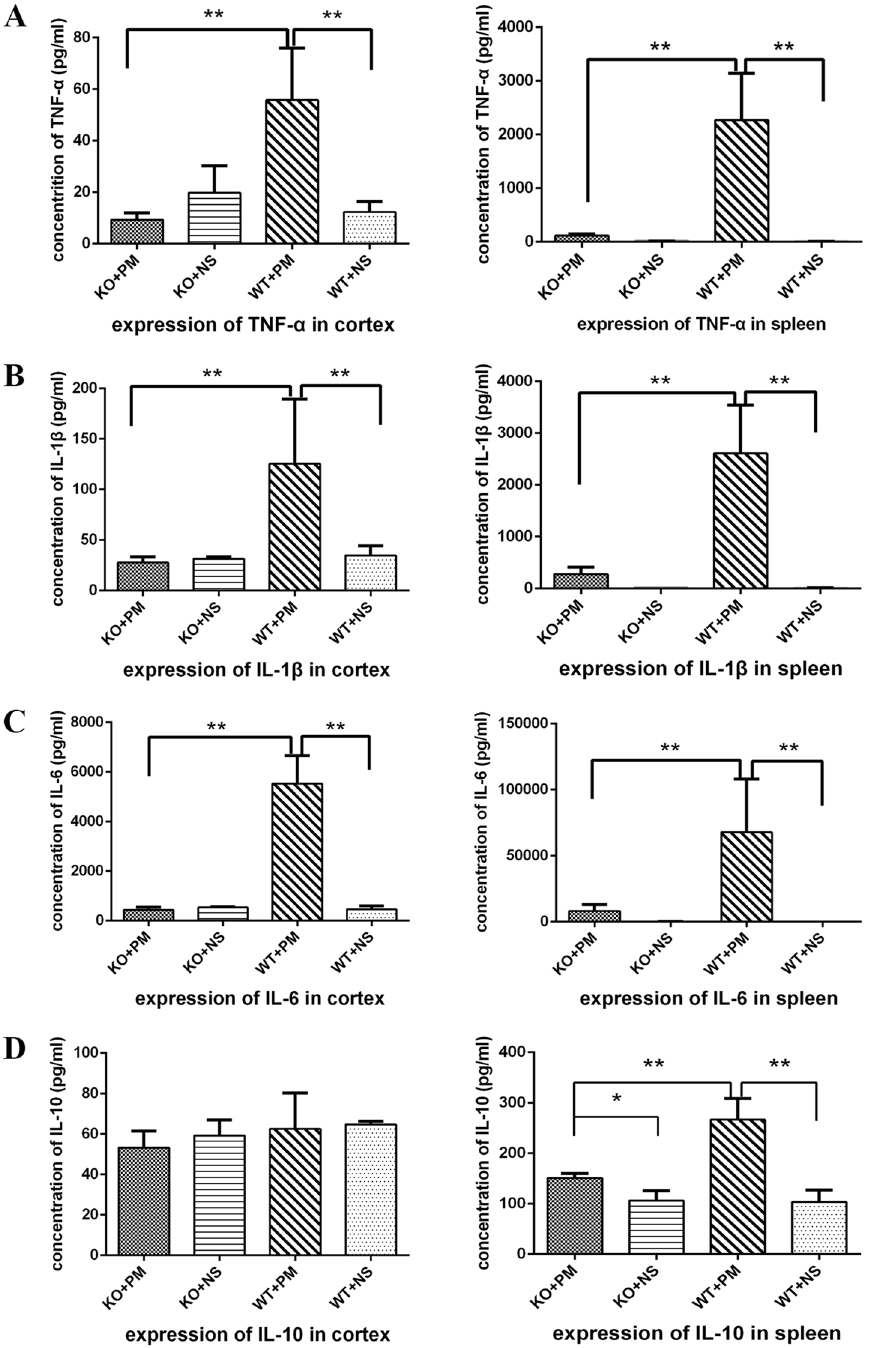
Figure 3. Effect of MyD88 deficiency on inflammatory mediator production in brains and spleens. myd88 − / − and wild-type mice received intracisternal injection of S. pneumoniae , and cytokine/chemokine expression in brains and spleens were evaluated using ELISA kits for ( A ) TNF- α , ( B ) IL-1 β , ( C ) IL-6, and ( D ) IL-10. In cortex and spleen homogenates from infected myd88 − / − mice, no significantly increased expression of TNF- α , IL-1 β , and IL-6 was detected. Inoculation with S. pneumoniae caused a significant increase in the expression of these inflammatory mediators in brains and spleens obtained from infected wild-type mice at 24 h after inoculation. Inoculation with S. pneumoniae led to increase of IL-10 in spleens both from infected myd88 − / − mice and infected wild-type mice at 24 h after inoculation. Moreover, the expression of this anti-inflammatory mediator was much higher in infected wild-type mice than in infected myd88 − / − mice. * p < 0.05, ** p < 0.01. KO: knockout, PM: pneumoniae meningitis, WT: wild-type, NS: normal